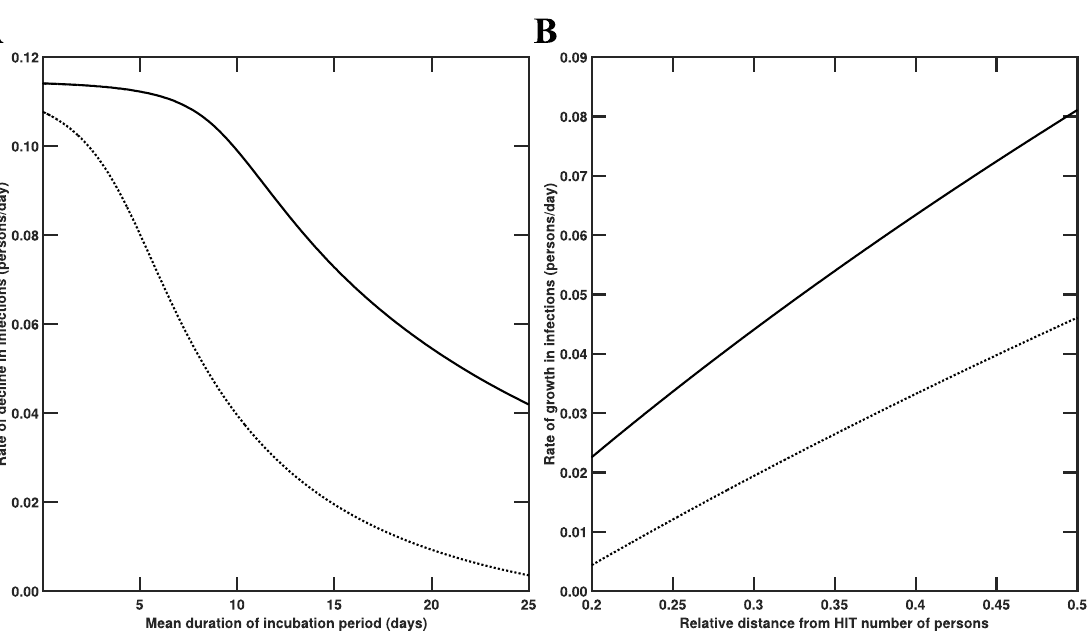
Figure 7. Dependence of disease burden on key model parameters for the states of New York and Washington. In each panel, the solid line corresponds to New York and the broken line corresponds to Washington. In Panel ( A ), rate of decline in infections is plotted as a function of the mean duration of the incubation period (in days), which is obtained as 𝑚/𝑘 𝐿 , where 𝑚 is the number of stages in the incubation period and 𝑘 𝐿 characterizes disease progression from one stage to the next. We take 𝑚 = 5 as in the study of Lin et al. [22]. In Panel ( B ), the rate of growth in infections is plotted as a function of the relative distance from the herd immunity threshold number of persons, which is defined as ε/𝑆 ℎ .